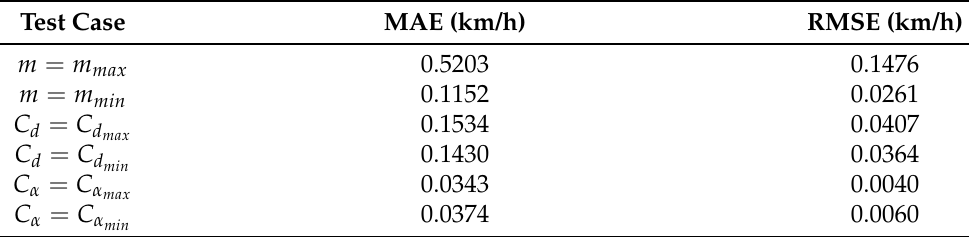
Table 10. MAE and RMSE for v x